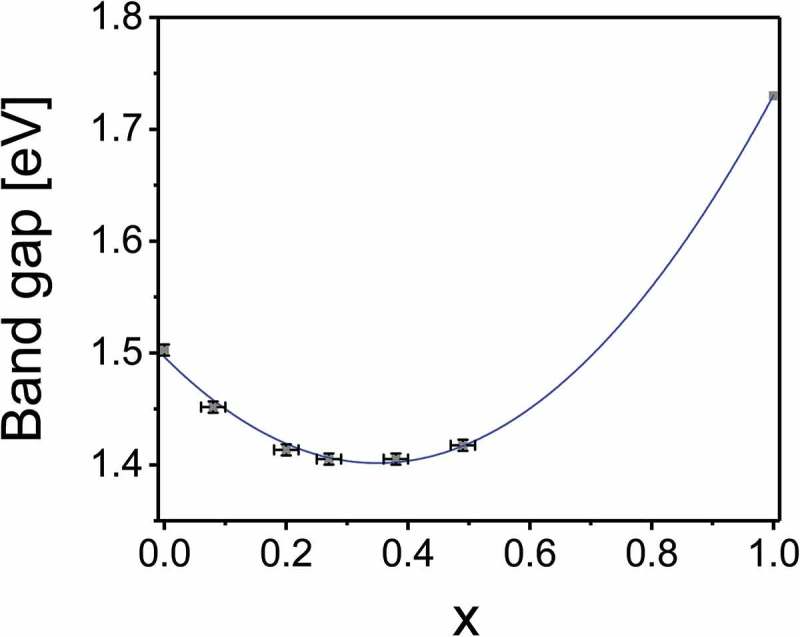
Band gap of CdTe1-xSex thin films on glass substrate determined from the Tauc plot. The band gap value for the pure CdSe (x = 1) was taken from literature [25].